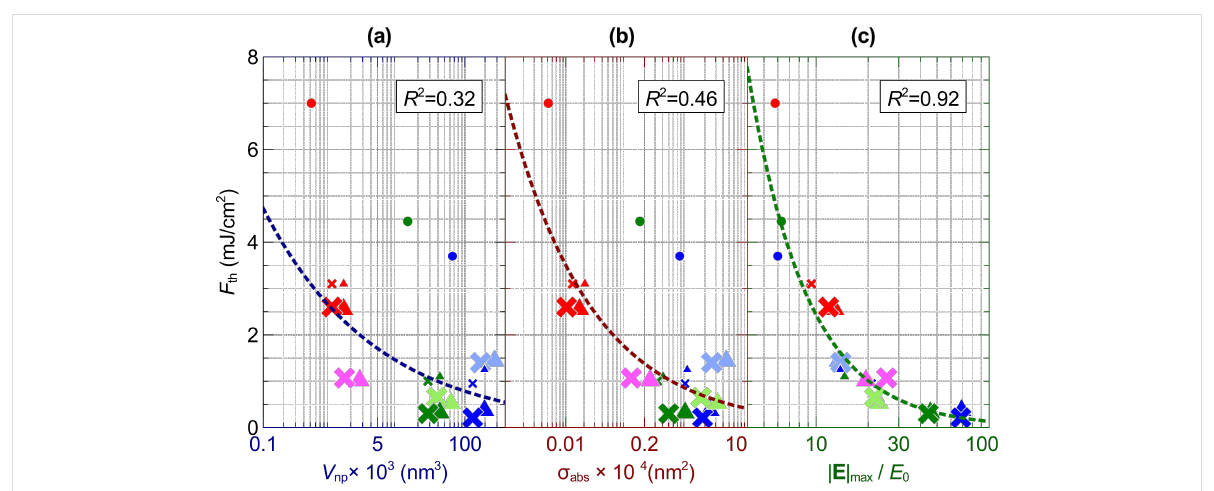
Figure 7: The optical breakdown threshold, F th , which is required to reach the critical electron density, ρ cr = 10 20 (cm − 3 ), is plotted against (a) the nanoparticle volume, V np , (b) the absorption cross section, σ abs , and (c) the maximum near-field enhancement, | E | max / E 0 . Symbols and color scheme are the same as in Figure 6 at ρ e = 10 20 cm − 3 .